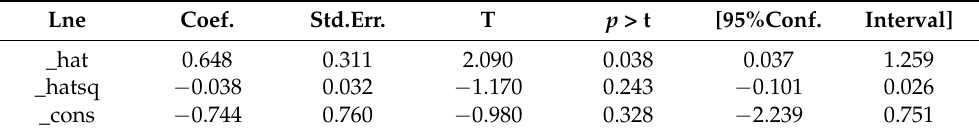
Table A2. Linktest